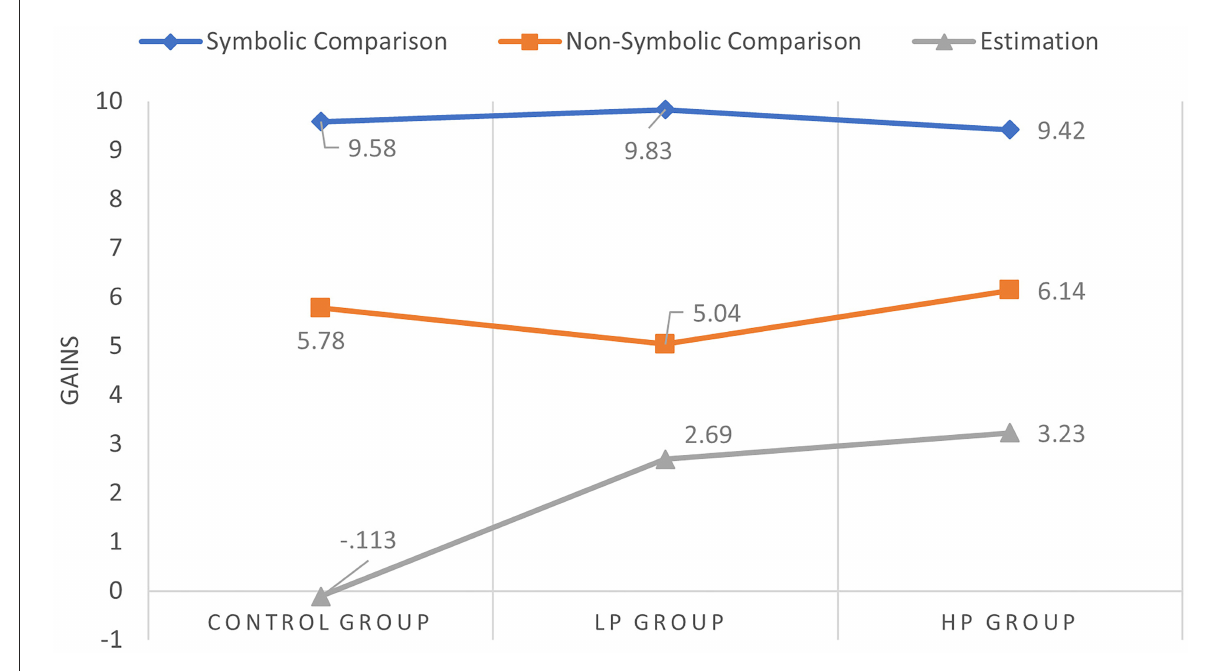
FIGURE3 Gains obtained by groups in each of the cognitive predictors assessed after the training programme.